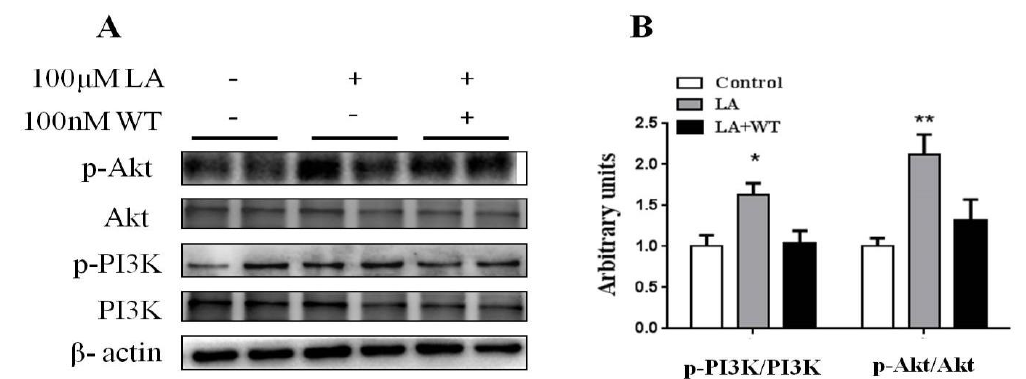
Figure 5. Inhibition of PI3K/Akt blocked the promotion of differentiated HC11 development by LA. ( A ) Western blot analysis of p-Akt, Akt, p-PI3K, PI3K in HC11 cell by DIP- induction. β -actin was used as loading control. ( B ) Mean ± SEM of the immunoblot bands of p-Akt/Akt, p-PI3K/PI3K, the intensities of the bands are expressed as arbitrary units (n = 4). * p < 0.05 versus control group. ** p < 0.01 versus control group.